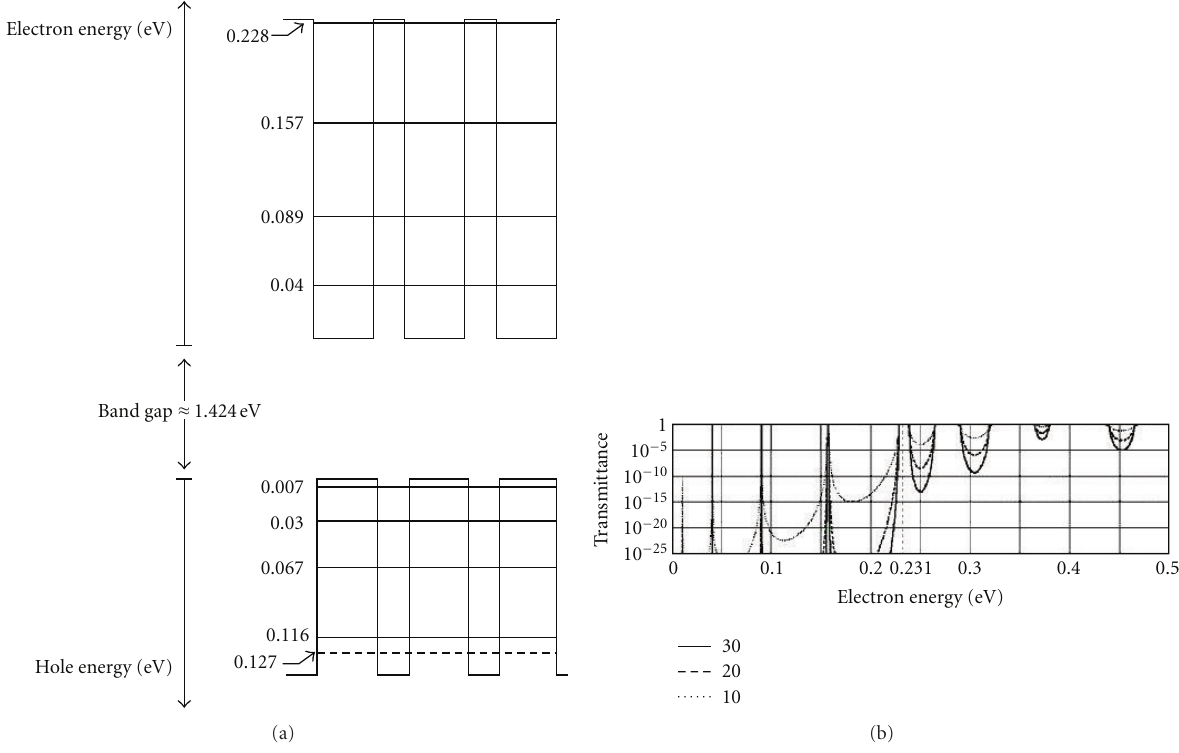
Figure 1: (a) Schematic representation of levels in the valence bands and conduction for the MQW system Al 0 . 3 Ga 0 . 7 As/GaAs containing 30 quantum wells. The corresponding level for the heavy gaps is shown with dotted line. (b) Transmission coe ffi cient based on the electron energy for the same system. The curves parameter is the number of quantum wells.